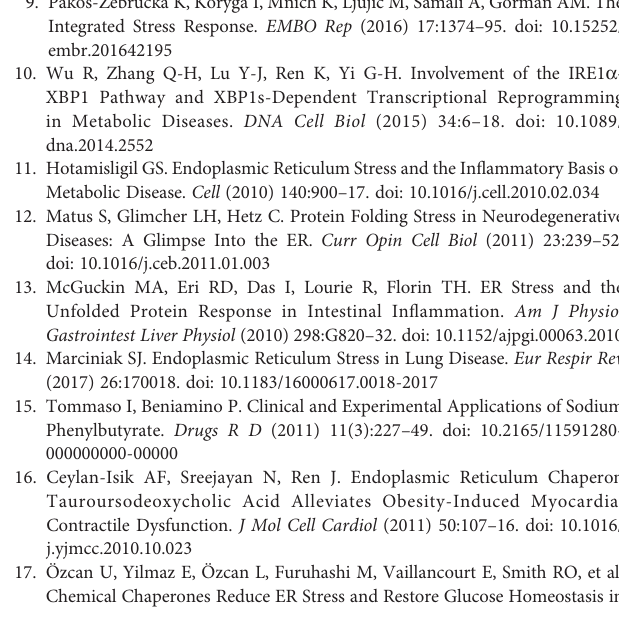
Supplementary Figure 1 | Survival was determined every 5 hours. The Kaplan – Meier survival curve was plotted. Mice administered 4-PBA 10 mg/kg had a higher survival rate versus the other three groups (p <0.001, log-rank test). Supplementary Figure 2 | MLE-12 cells were transfected with varying doses of claudin-4 siRNA and immunoblotted against claudin-4 or b -actin (loading control). Supplementary Figure 3 | Two doses of claudin-4 siRNA were administrated intratracheally. These lung lysates were immunoblotted against claudin-4 or b -actin (loading